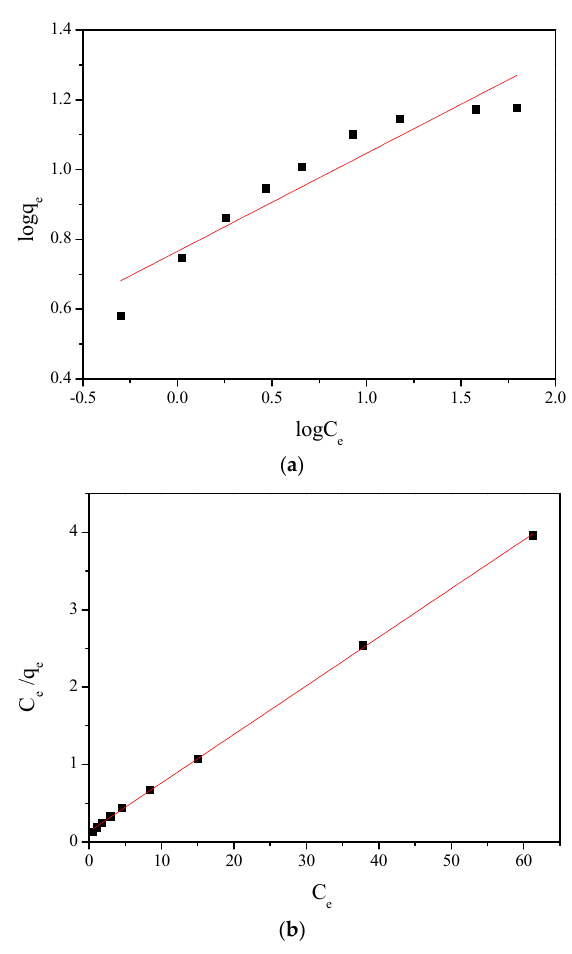
Figure 10. Freundlich and Langmuir isotherm plots for the adsorption of Ni 2+ ( a ) Freundlich; ( b ) Langmuir. Table 3. The constants and correlation coefficients of Freundlich and Langmuir isotherm plots for the adsorption of Ni 2+ .